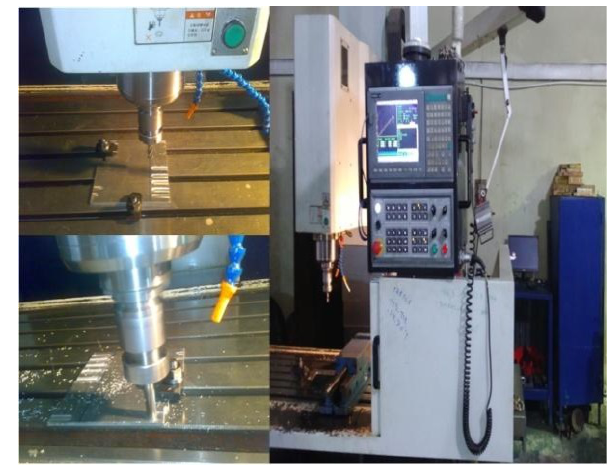
Figure 2. The CNC milling